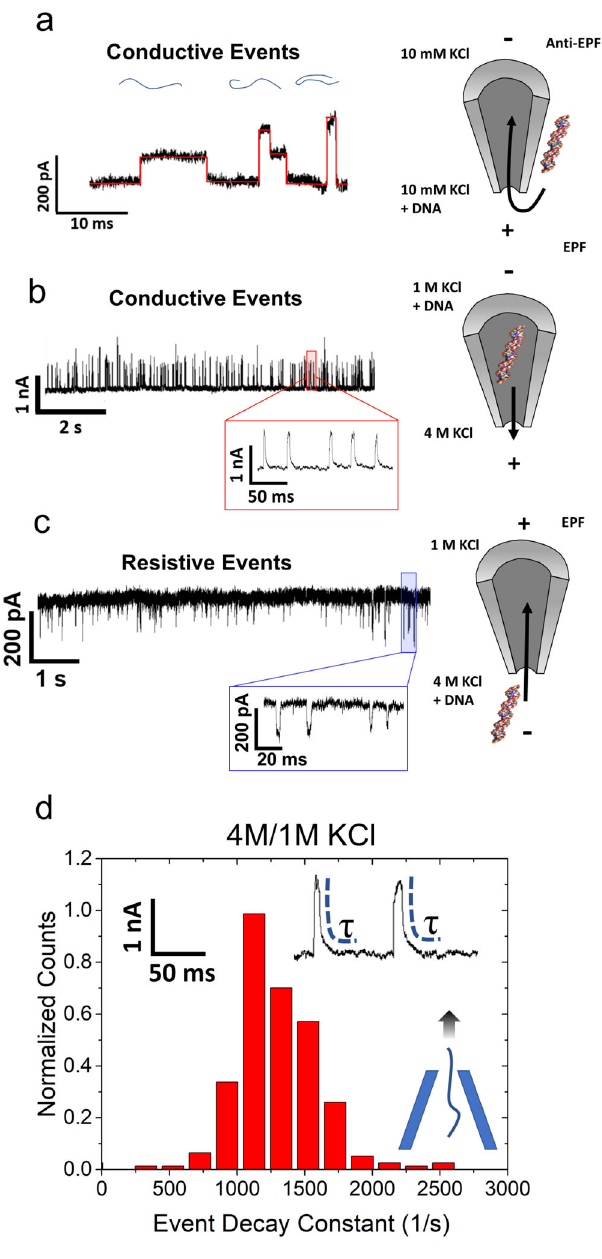
Fig. 2 Event properties of DNA under low ionic strength and asymmetric salt conditions. a Typical event structures observed with λ -DNA translocation experiments under low salt, symmetric conditions at − 600 mV. The three events correspond to linear, partially folded, and fully folded λ -DNA from left to right (current traces in black overlaid with red lines). The corresponding blue lines show an example of each DNA con fi guration. The schematic on the right displays the salt conditions as well as the voltage applied to either side (denoted by positive or negative signs) and how λ -DNA enters via EOF (anti-EPF) from the capture zone located at the outer walls of the nanopore. b Observation of CEs in asymmetric salt conditions when λ -DNA + 1 M KCl was added into the pipette and 4 M KCl was outside at − 600 mV. To the right, EPF is used to repel λ -DNA away from the negatively applied voltage and exit the pore into the bath solution. Red inset: DNA exiting the pore produces CEs containing a tail before returning back to baseline. c Current traces of REs in asymmetric salt conditions when λ -DNA + 4 M KCl was added into the bath and the pore contained 1 M KCl. Located to the right is a schematic showing how DNA is electrophoretically attracted to translocate into the pore when + 600 mV is applied. All buffers were prepared at pH 7.4. Blue inset: DNA entering the pore yields REs that look similar to square pulses. d Event decay to equilibrium for the case experiments shown in b . DNA is exiting the pore and thus should immediately leave the sensing zone of the pore as opposed to the reverse translocation